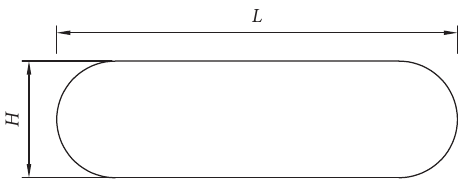
Figure 20: Cross section of round ended pier. Table 6: Structural parameters of high-speed railway